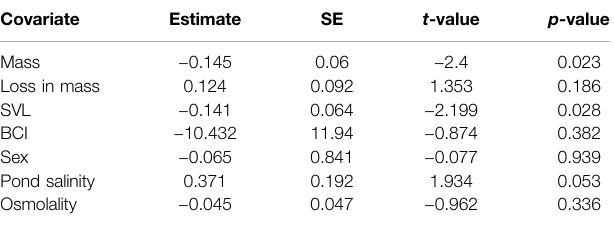
TABLE 3 | Effects of mass, loss of mass, SVL (size), body condition, sex, pond salinity and osmolality on individual mortality in the 12 g L − 1 salinity treatment (computed only on individuals exposed to the 12 g L − 1 salinity treatment, N = 33